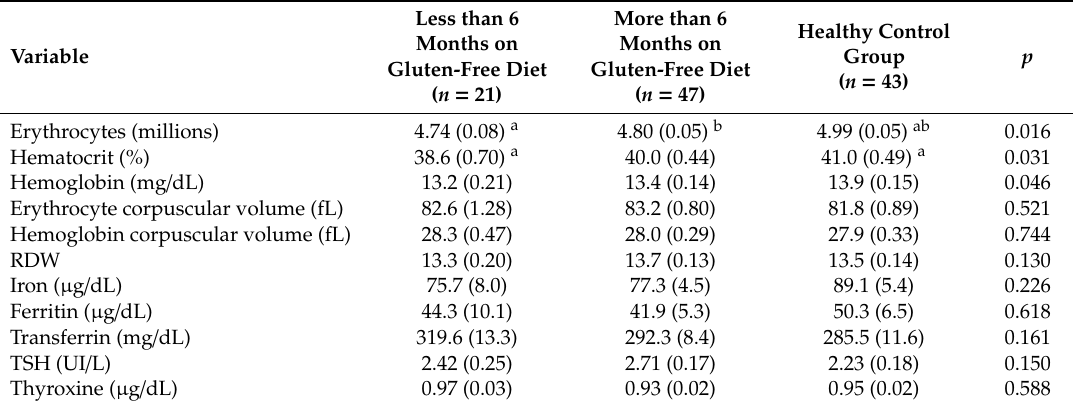
Table 2. Di ff erences between healthy control children, patients with a gluten-free diet in the last 6 months and patients with a gluten-free diet less than 6 months on serum hematological and biochemical anemia-related markers.